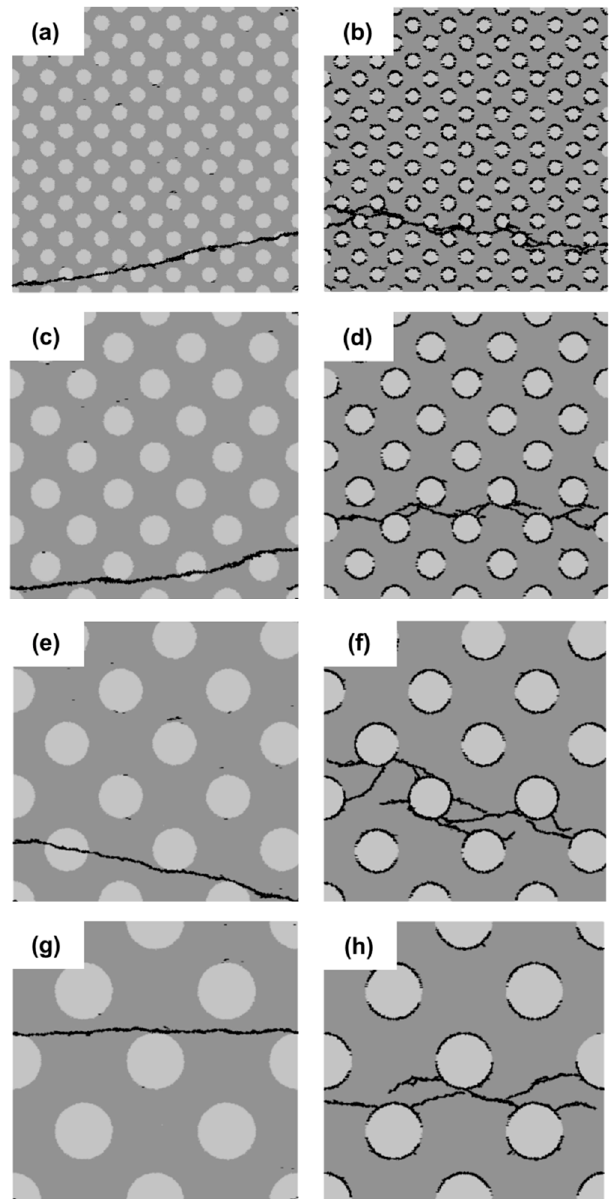
Figure 7. Micro-crack patterns of specimens with uniformly-distributed filler particles for different filler particle sizes (5 µm ( a , b ), 10 µm ( c , d ), 15 µm ( e , f ) and 20 µm ( g , h )).